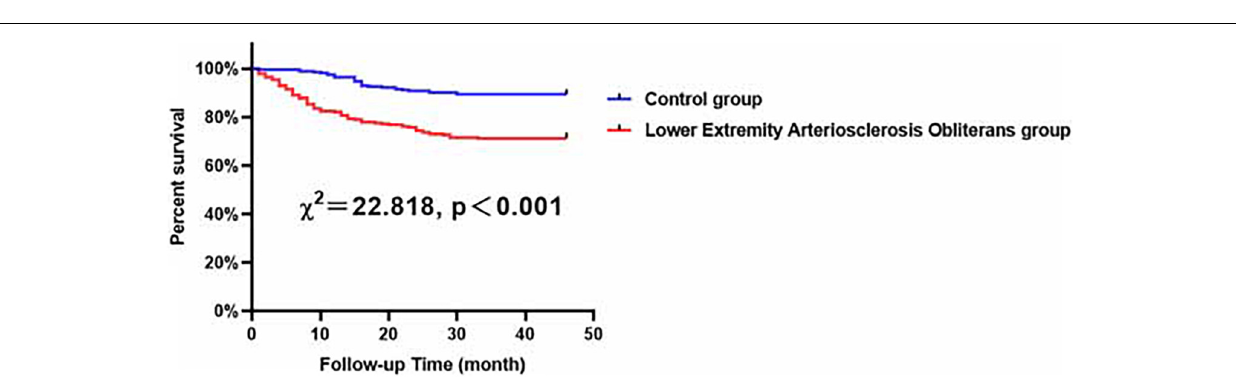
FIGURE 3 | Major adverse cardiovascular and cerebrovascular events-free survival rates for male patients with LEASO group and control group during the follow-up